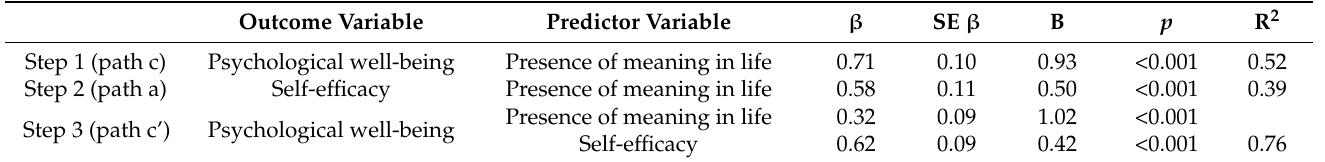
Table 4. Multiple regressions analysis on the mediating effects of self-efficacy (n =